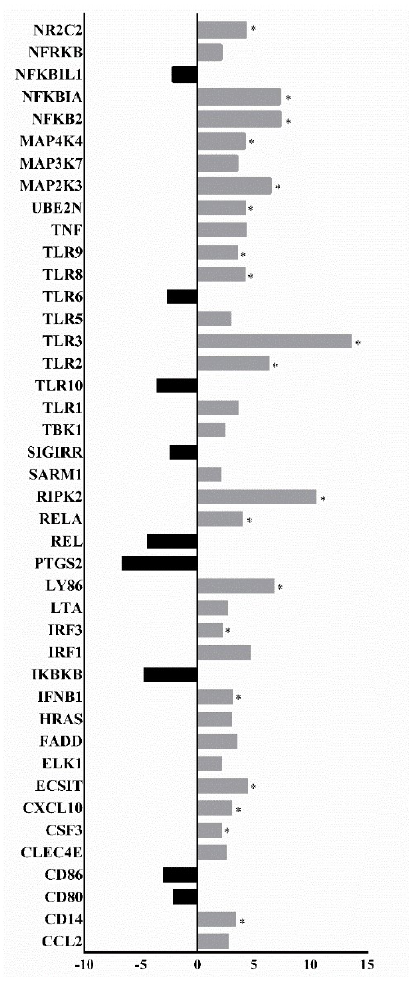
Figure 1. Gene expression profile comparisons between COVID-19 patients who died vs. the asymptomatic, mildly symptomatic, and moderately/severely symptomatic groups. Upregulation (gray) and downregulation (black) of genes linked to immune response activation pathways are indicated. Statistical significance ( p < 0.05) is represented by an asterisk (*) (nonparametric Mann–Whitney One-tailed test, GraphPad Prism ® version 6.01).